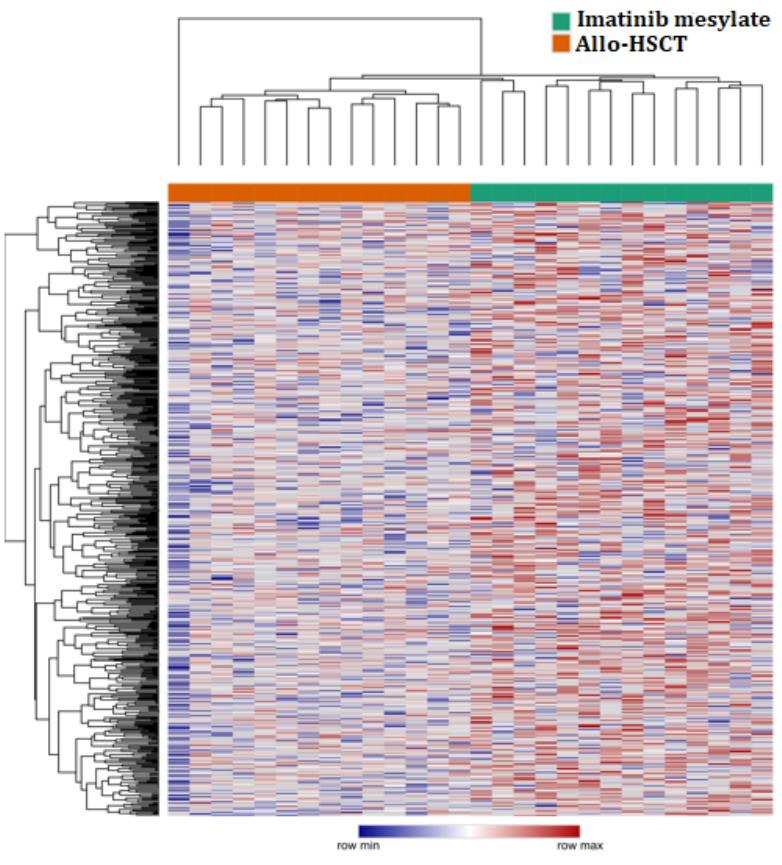
Figure 1. Heatmap of the normalized expression values of microRNAs in allo-HSCT and imatinib mesylate groups.